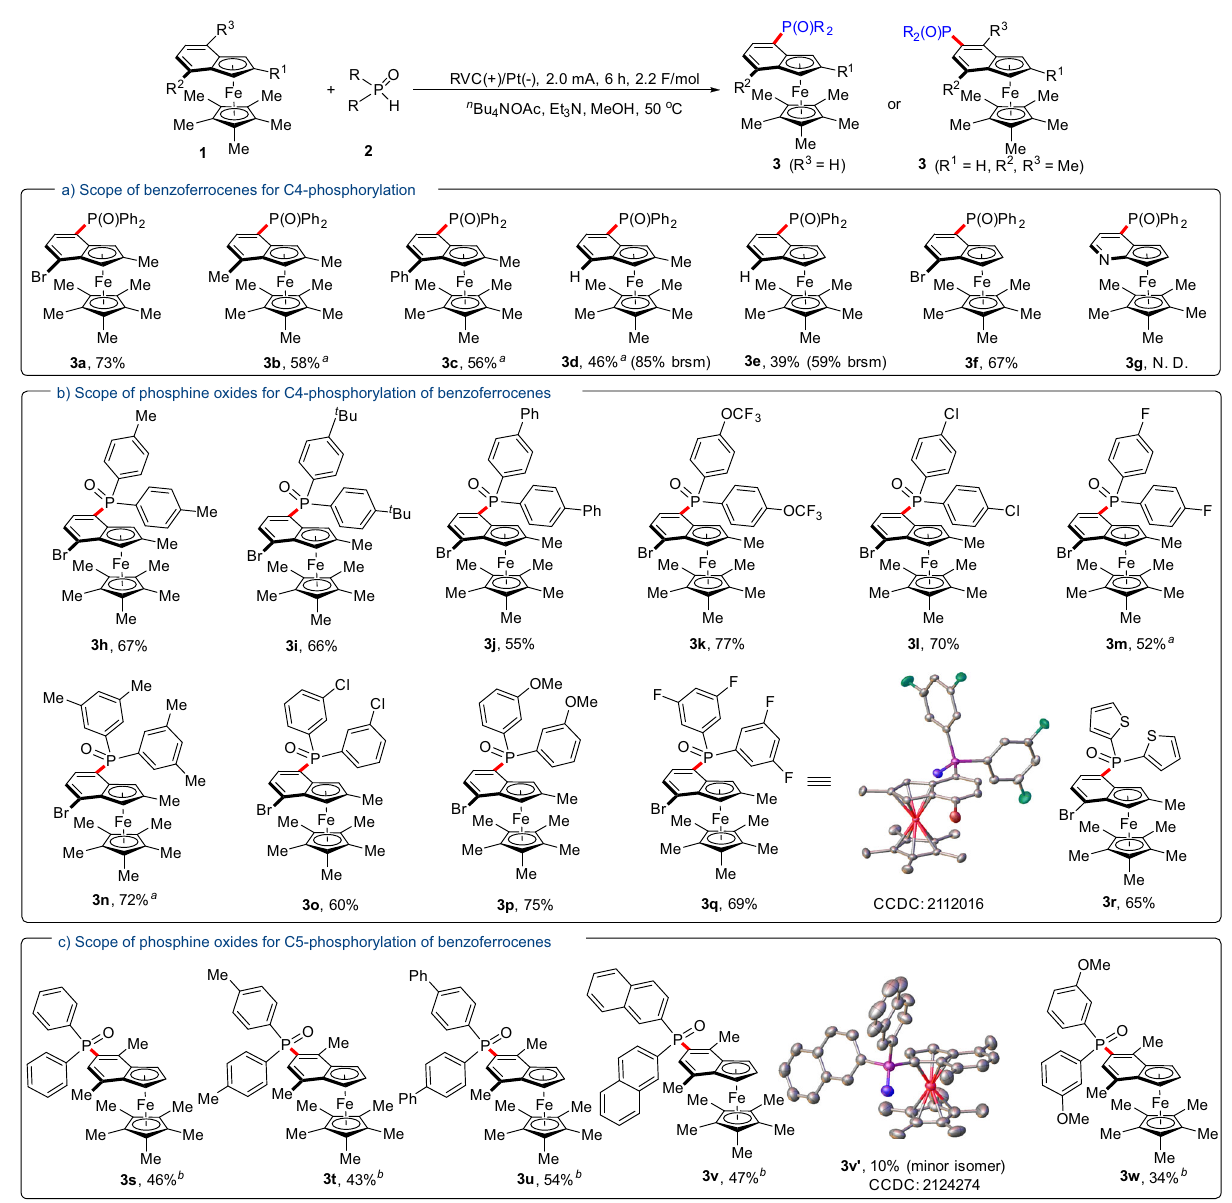
Fig. 2 Substrate scope. a Scope of benzoferrocenes for C4-phosphorylation. b Scope of phosphine oxides for C4-phosphorylation of benzoferrocenes. c Scope of phosphine oxides for C5-phosphorylation of benzoferrocenes. a Reaction with 2.5 mA, 6 h (2.8 F/mol). b Reaction with 3.0 mA, 10 h (5.6 F/mol). Brsm refers to the yield based on the recovered starting